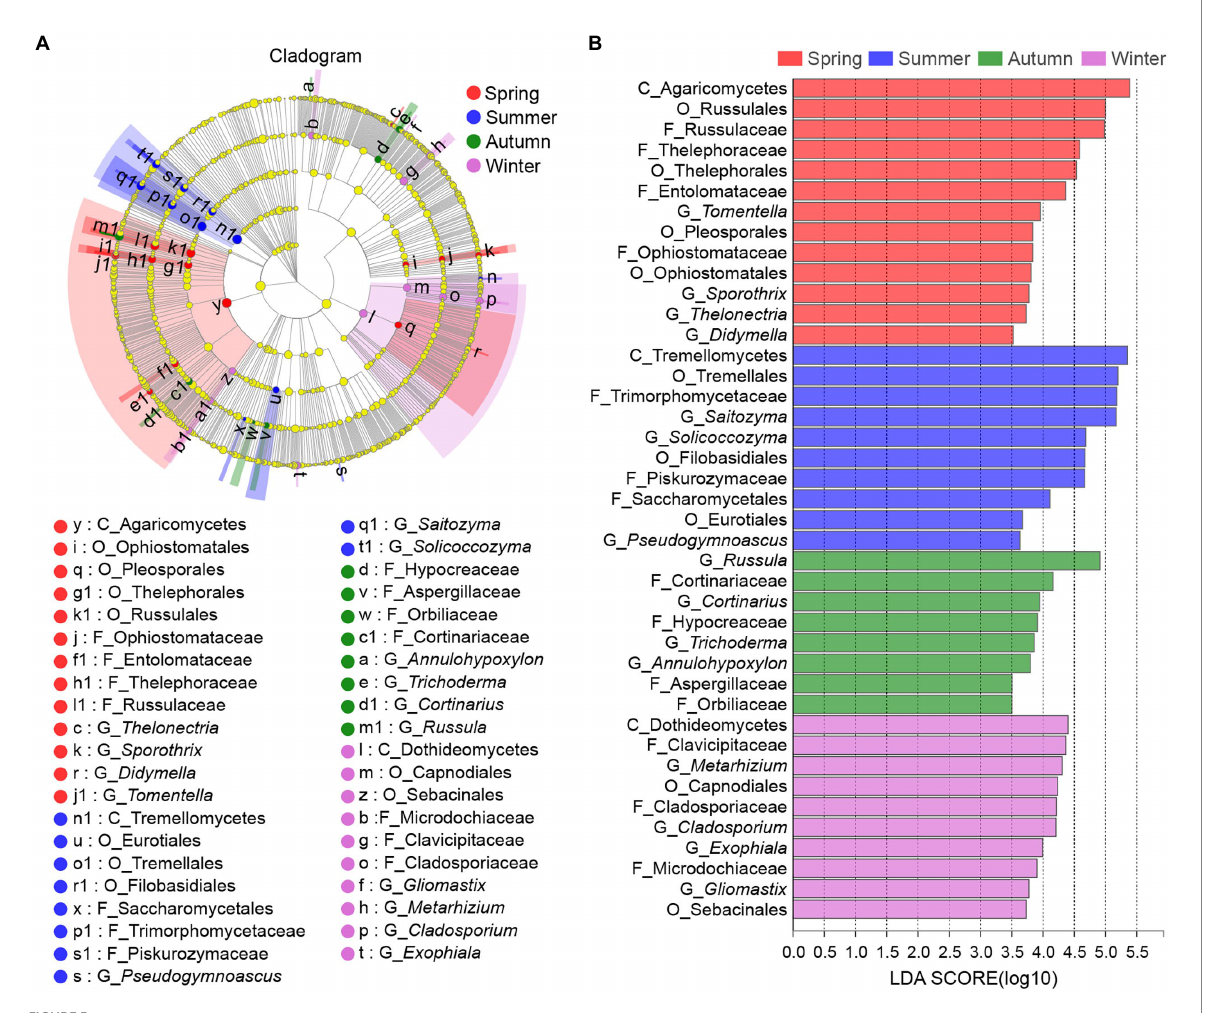
FIGURE 5 LEfSe analysis of fungal abundance in rhizosphere of C . pingbianense in four seasons. (A) Cladogram showing taxa with different abundance values of fungal community. (B) LDA bar chart of fungal